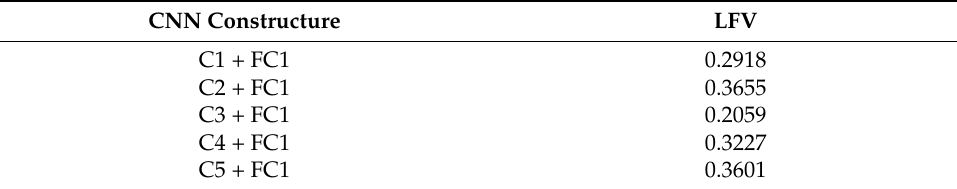
Table 4. LFVs of different Conv layers with one FC layer.